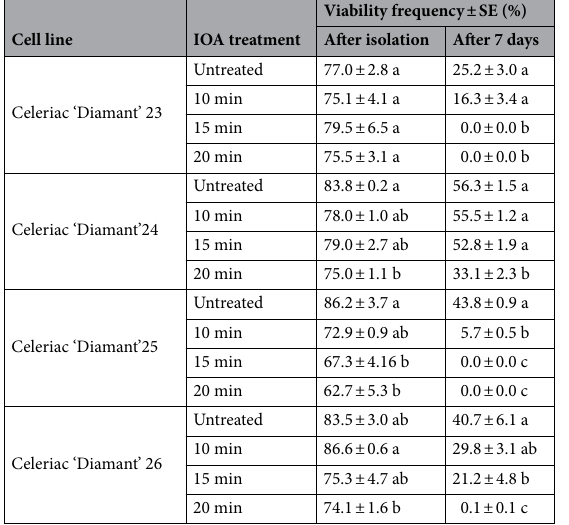
Table 2. The viability frequencies (%) of acceptor (celeriac ‘Diamant’) suspension protoplasts upon IOA treatment. Data shown are means (n = 6, ± SE). a, b, c significant differences based on Tukey’s honest significant test, p <